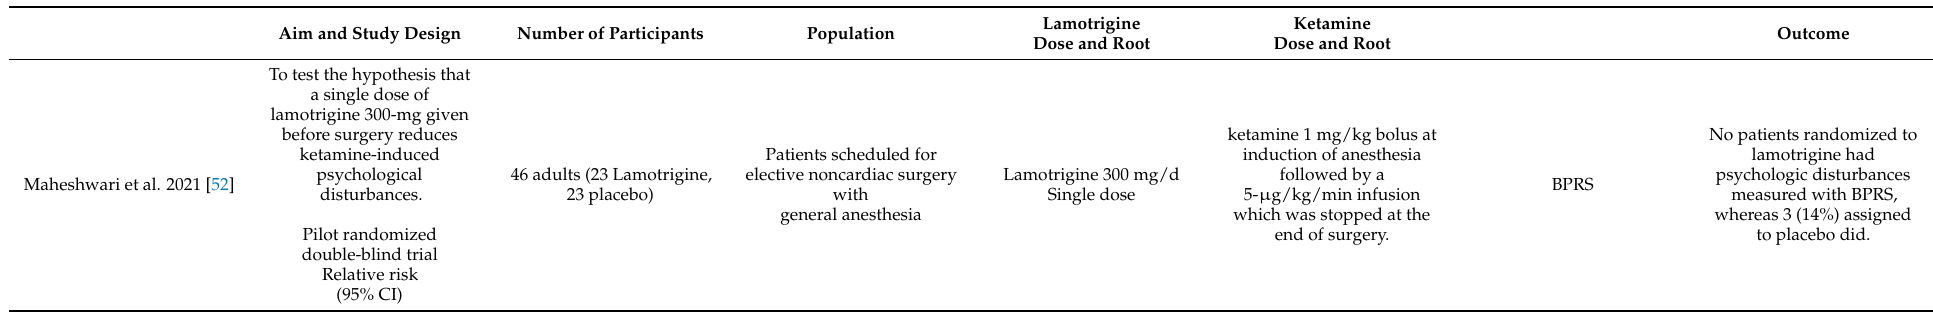
Table 4. Human study in substance use disorder.